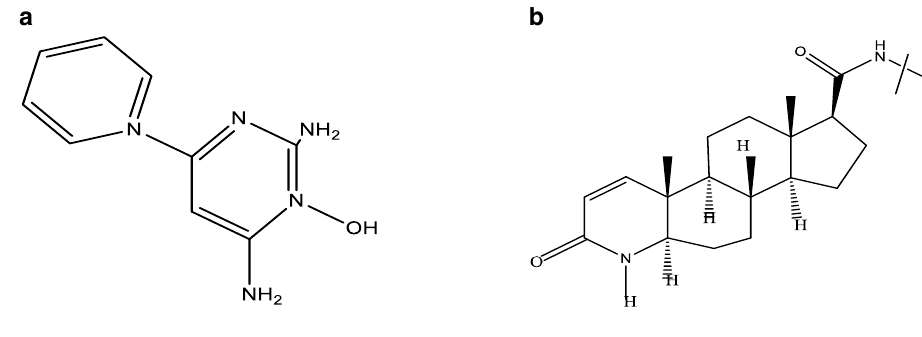
Fig. 2 a Chemical structure of Minoxidil. b Chemical structure of Finasteride